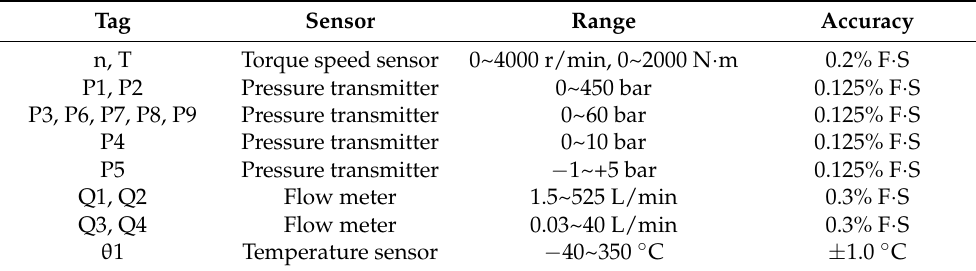
Table 3. Technical characteristics of measuring